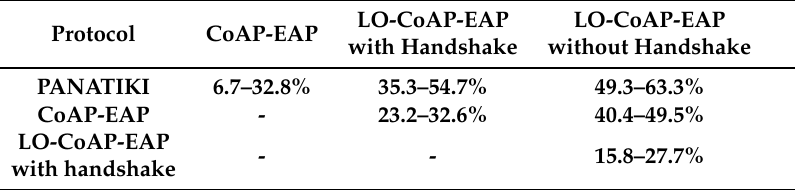
Figure 8. Total energy consumption in Cooja for LO-CoAP-EAP, CoAP-EAP and PANATIKI. ( a ) Total energy consumption with a 0.0 loss ratio; ( b ) total energy consumption with a 0.1 loss ratio; ( c ) total energy consumption with a 0.2 loss ratio. Table 6. Energy consumption